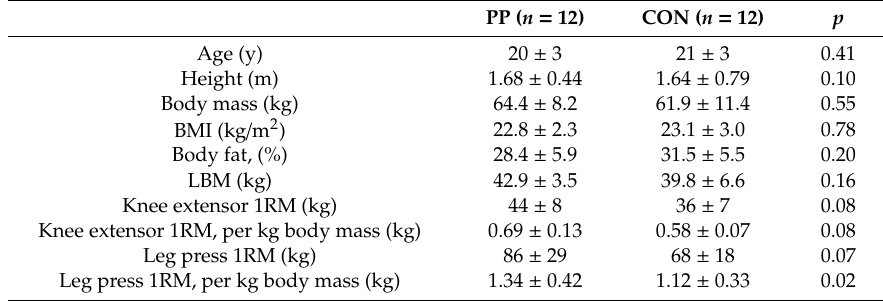
Table 2. Participants’